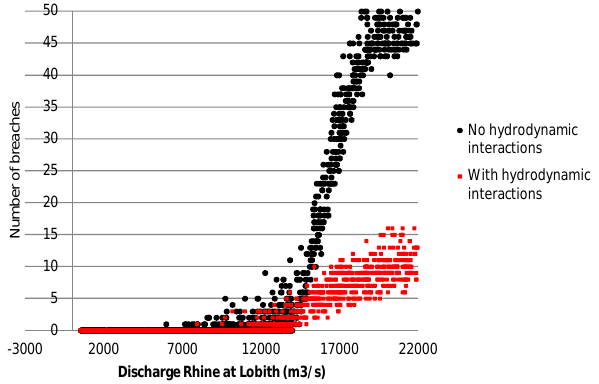
Figure 6. Effect of hydrodynamic interaction on the number of breaches in the non-tidal part of the